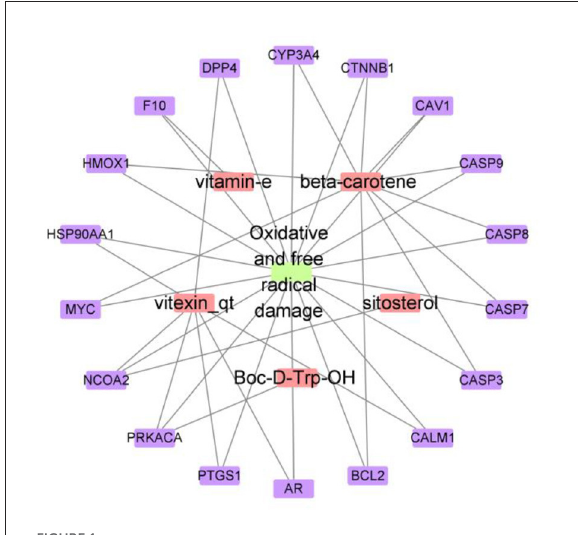
FIGURE1 The network of compound–target interactions.